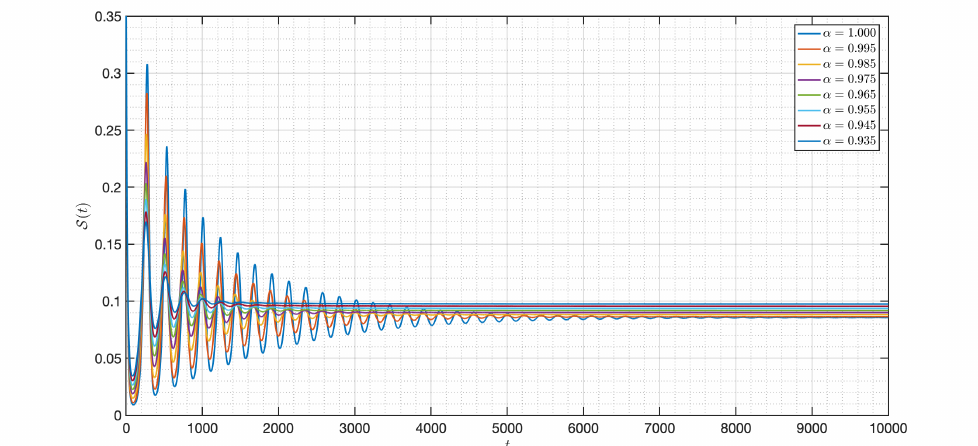
Figure 2. Dynamic of N ( t ) of the model (3) for different order α in Case I .